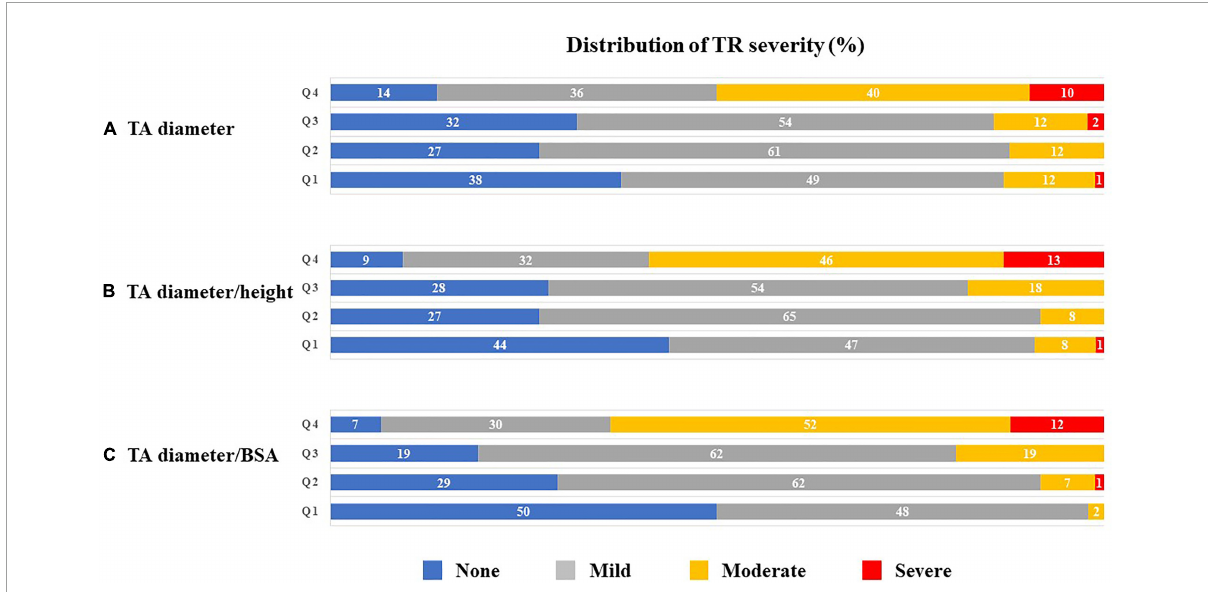
FIGURE3 Distribution (%) of TR severity according to quartiles of TA diameter (A) , TA diameter/height (B) and TA diameter/BSA (C) . BSA, body surface area; TA, tricuspid annulus; and TR, tricuspid regurgitation.